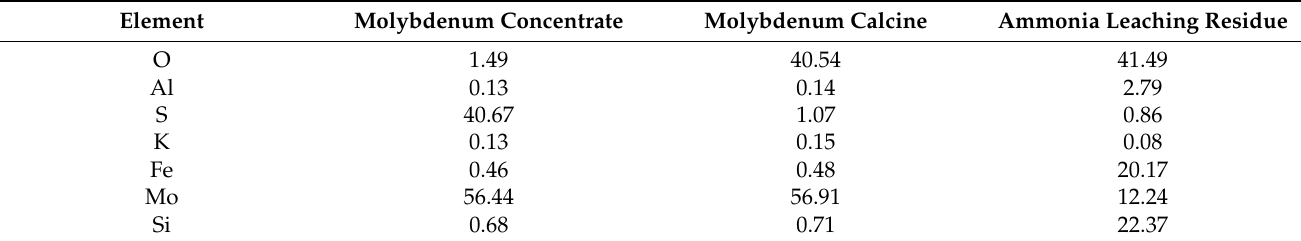
Table 1. EDS analysis of main elements in different samples/%.